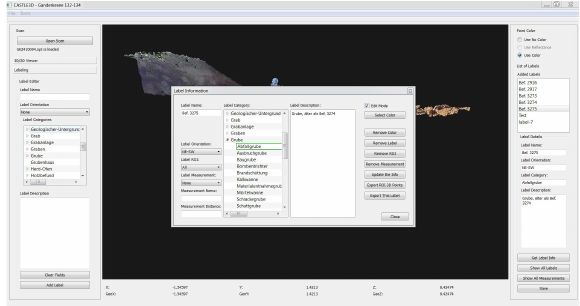
Figure 13: Presentation of CASTLE3D with added labels and selected regions of